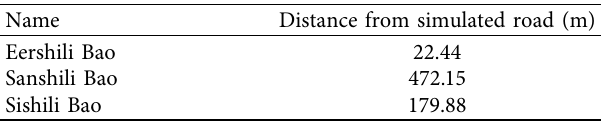
Table 9: The shortest straight-line distances between the connected Bao and the simulated path. Name Distance from simulated road